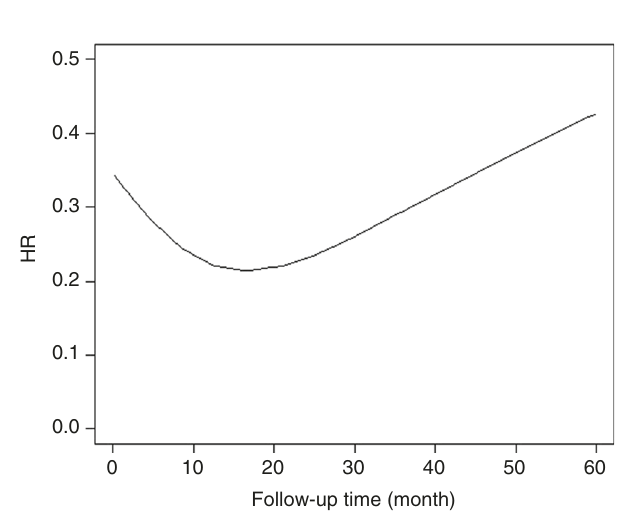
Fig. 1 A nonparametric estimate of the hazard ratio as a function of